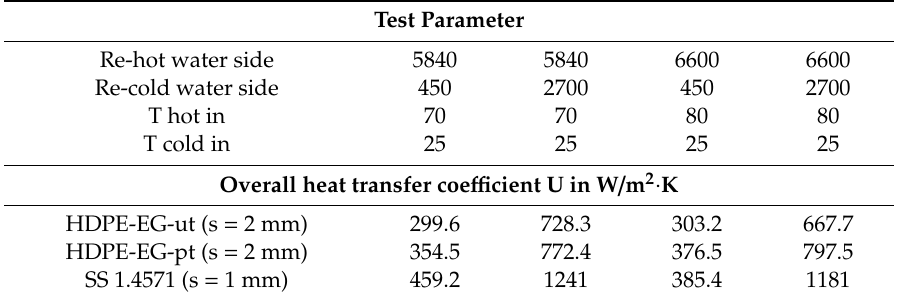
Table 1. Measured overall heat transfer coe ffi cients for the investigated materials for various test